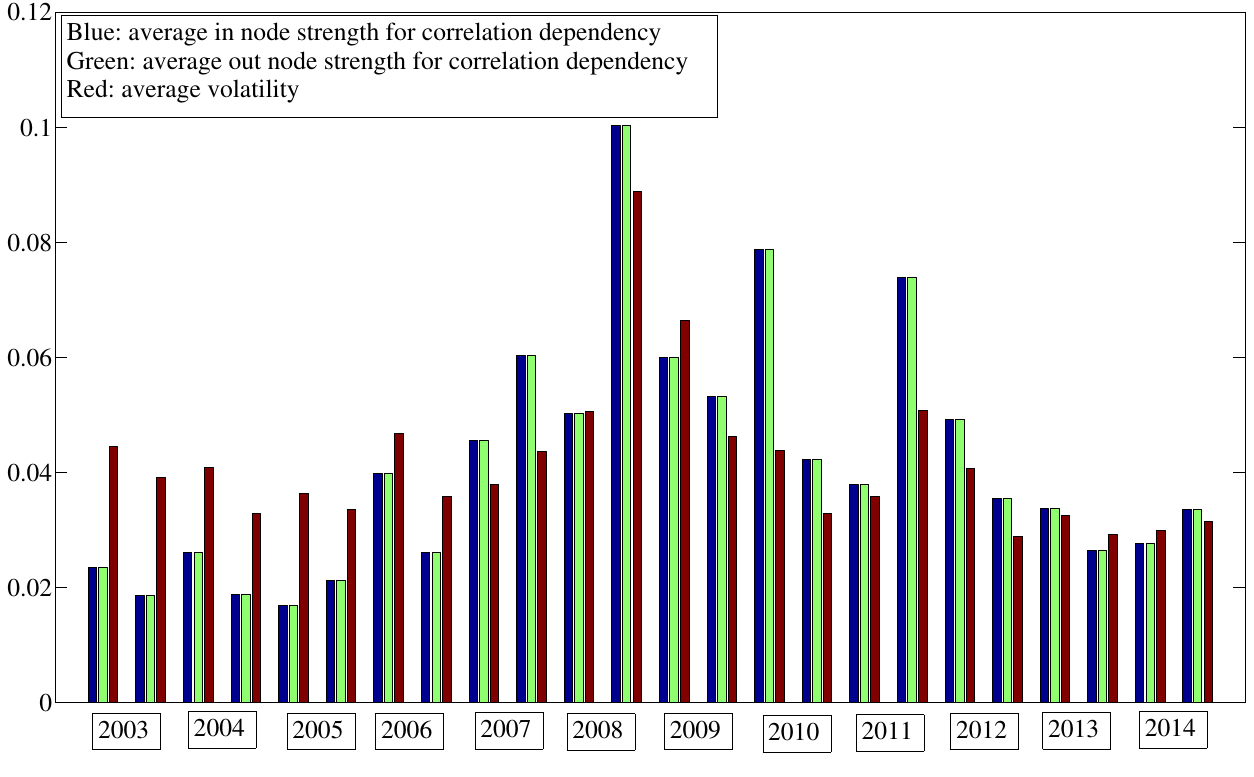
Figure 16. Average correlation dependency × average volatility.